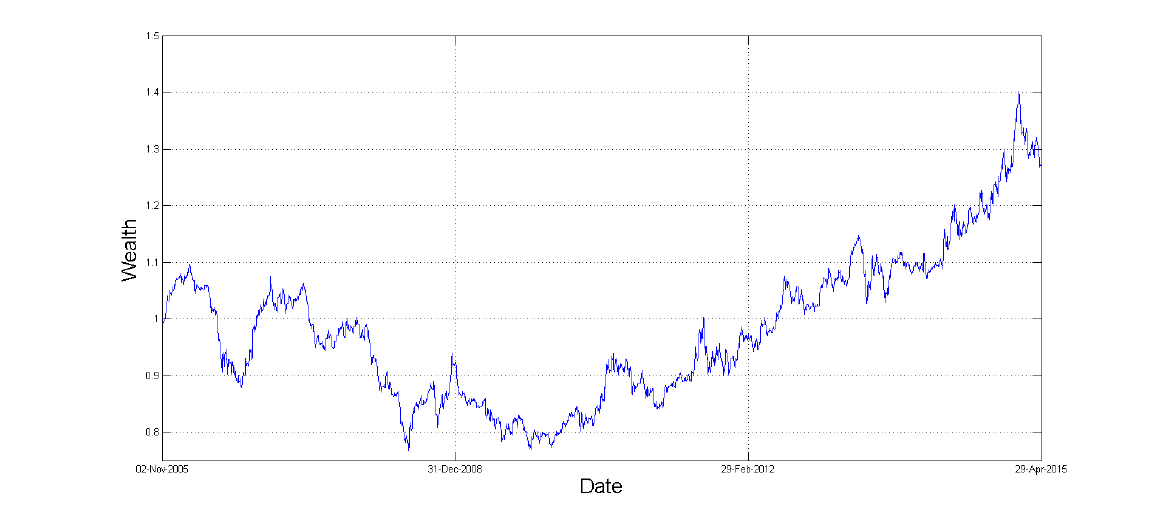
Figure 10. Ex-post wealth on South African